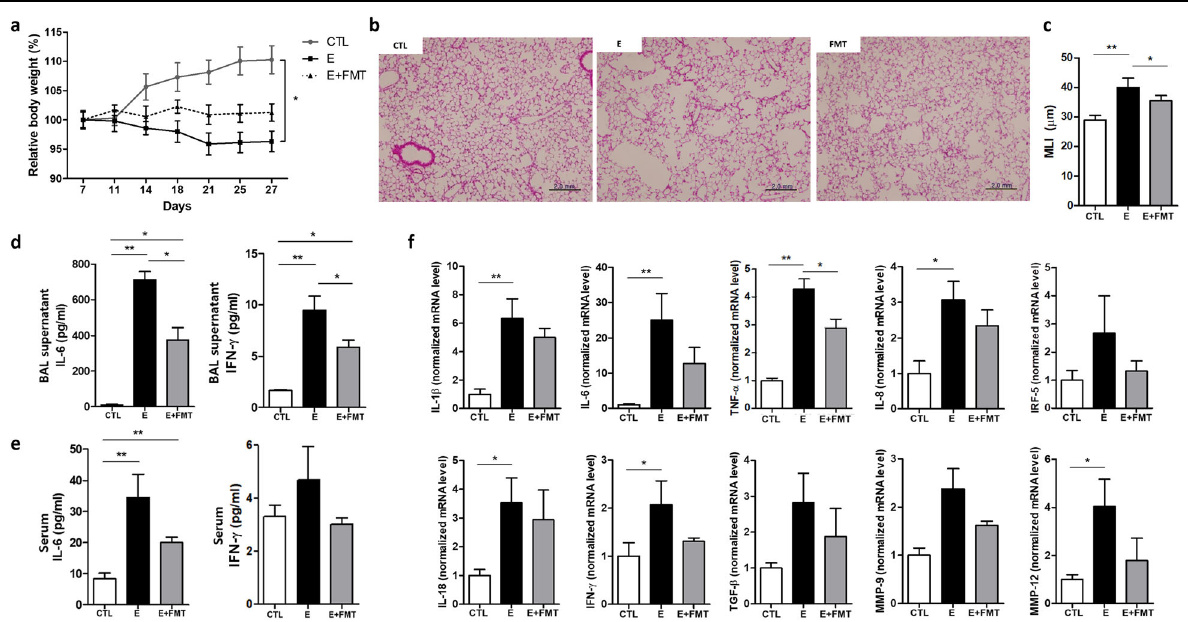
Fig. 1 The effect of fecal microbial transplantation on emphysema development (Experiment 1). a Relative body weight change during 4 weeks of the experimental period. b Representative H&E-stained lung tissues from control, emphysema, and emphysema with FMT mice (magni fi cation: 100×). c The mean linear intercept (MLI) of lung tissues from each group. d, e The levels of IL-6 and IFN- γ cytokines in the BALF ( d ) and serum ( e ) measured by ELISA. f The relative mRNA levels of IL-1 β , IL-6, TNF- α , IL-8, IRF-5, IL-18, IFN- γ , TGF- β , MMP-9, and MMP-12 in lung tissues ( n = 5 mice per group). Values are expressed as the mean ± SE. * P < 0.05 and ** P < 0.01. CTL control, E emphysema, FMT fecal microbial